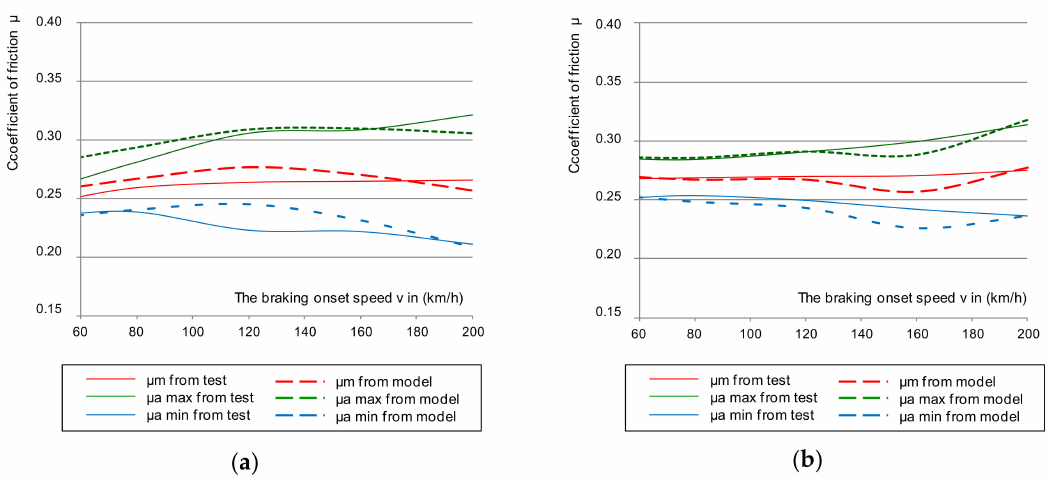
Figure 12. The changes of µ m from the tests with multiple regression model during braking on the G 1 lining with N = 25 kN, M = 5.7 t for: ( a ) smooth disc, ( b ) perforated disc.